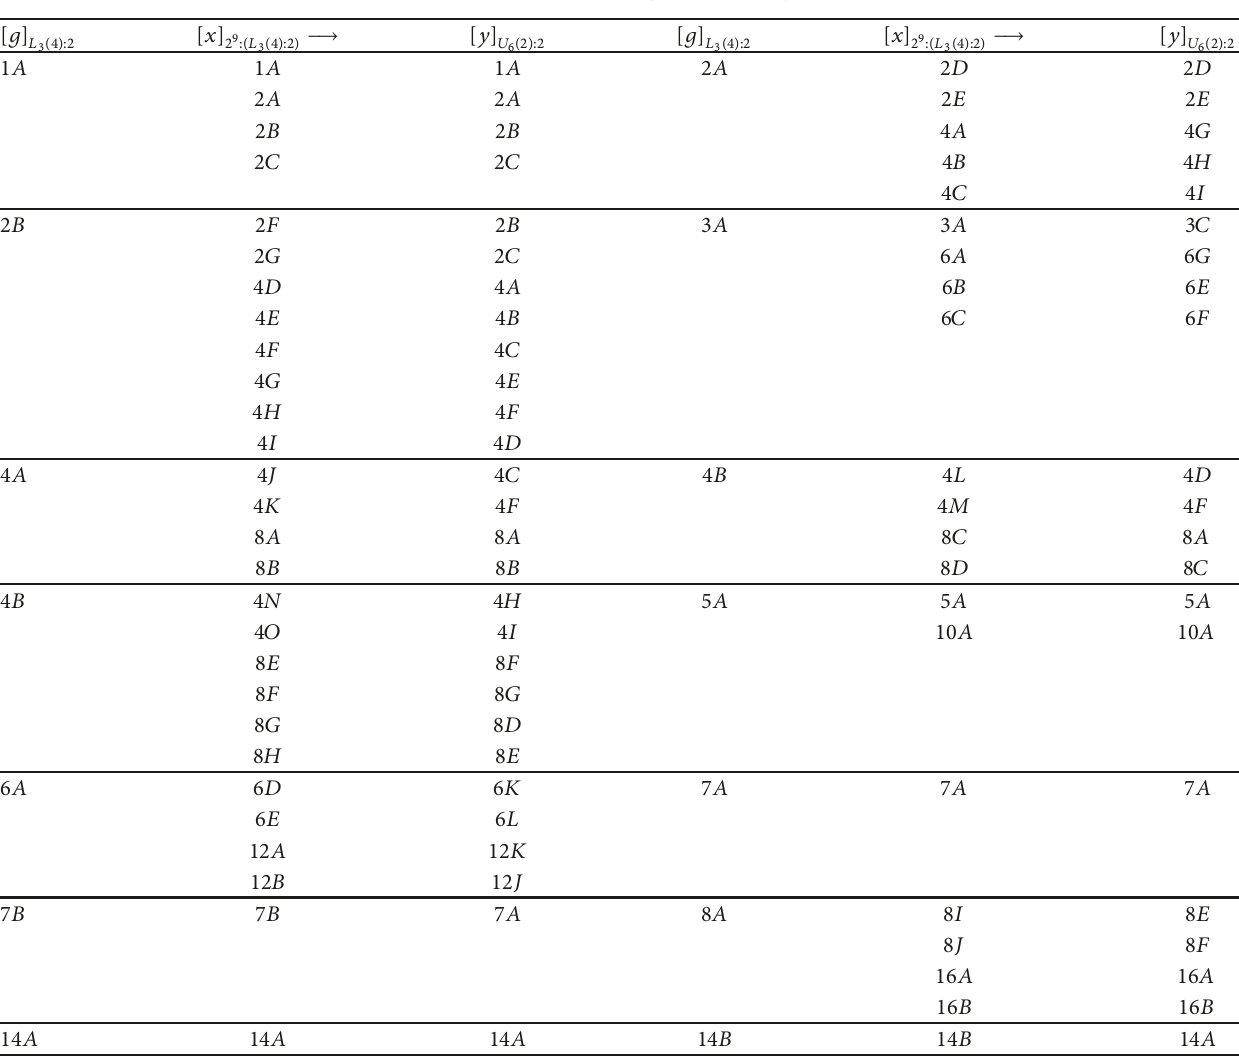
Table 9: The fusion of 2 9 : (𝐿 3 (4) : 2) into 𝑈 6 (2) : 2